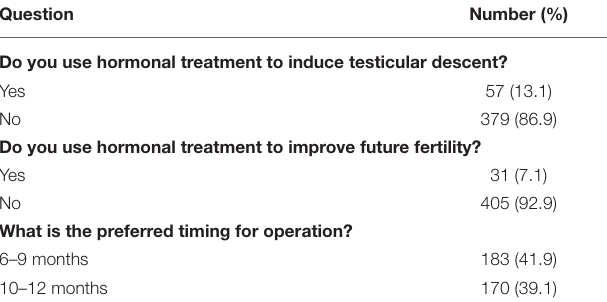
TABLE 1 | Management practices evaluated in the